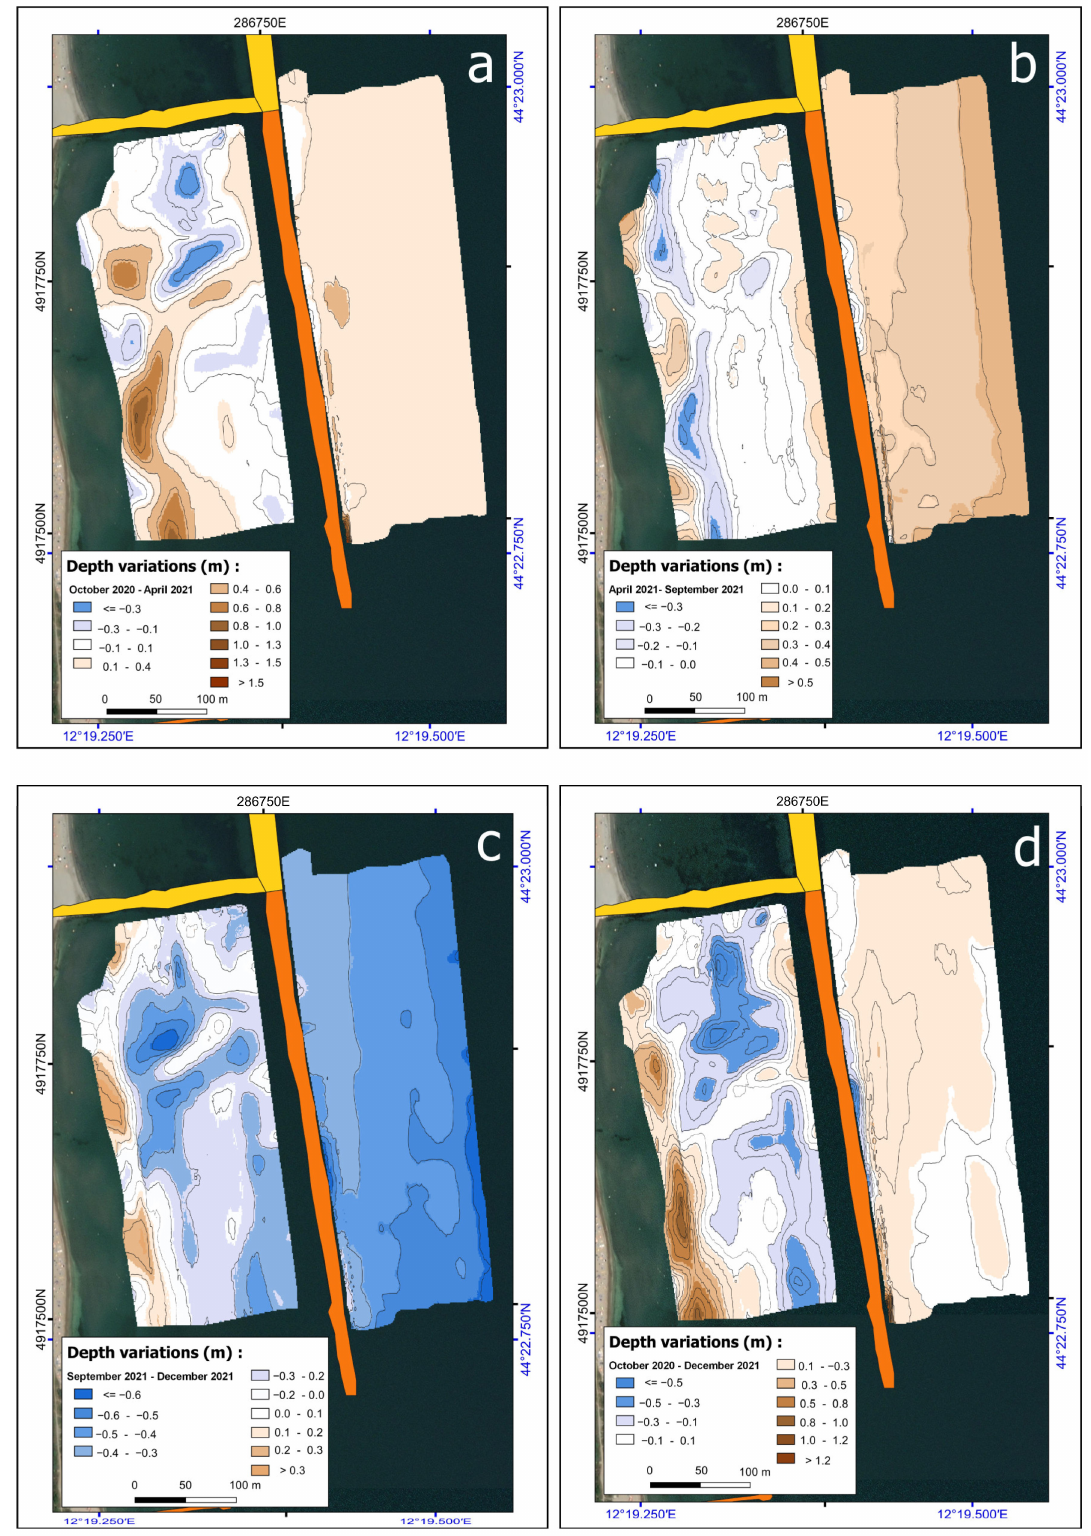
Figure 12. Differences in seafloor models between DTMs during the experiment. Comparisons are between subsequent surveys ( a – c ) and between the first and last surveys ( d ). Brownish colors indicate seafloor accretion, while blue colors indicate negative sedimentary